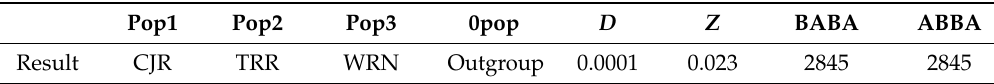
Table 1. Gene flow determination among different groups.